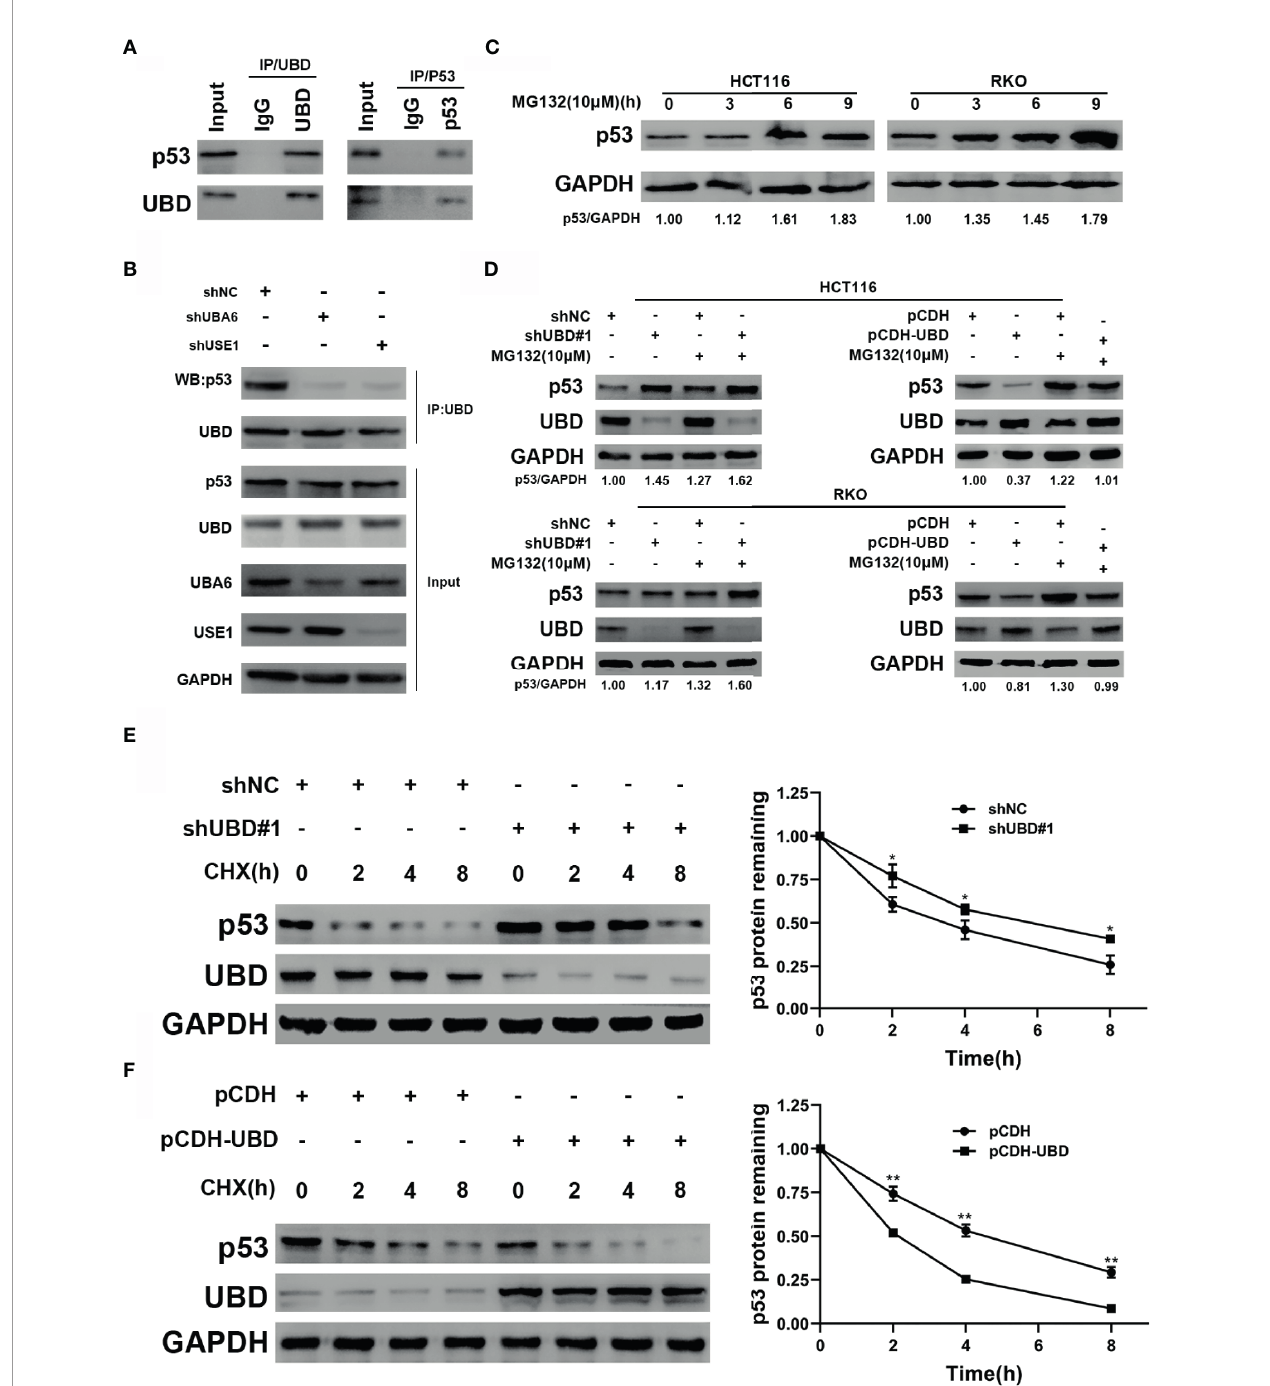
FIGURE 6 | UBD inhibits p53 stability by enhancing the protein degradation of p53. (A) Immunoprecipitaion of endogenous UBD and p53 in HCT116 cells. (B) UBD-p53 complexes were examined in HCT116 cells transfected with the indicated shRNAs (C) Western blot analysis of p53 expression in cells treated with MG132 (10 m M) for the indicated times. (D) After transfection with the shNC, shUBD#1, pCDH or pCDH-UBD plasmids, p53 expression in HCT116 and RKO cells was observed upon addition of MG132 (10 m M) for 6 hours by using Western blotting. (E , F) HCT116 cells were transfected with shNC or shUBD#1 (E) , RKO cells were transfected with pCDH or pCDH-UBD (F) . Then treated with 100 m g/mL CHX for the indicated times. Western blotting was used to detect the UBD and p53 expressions. Quantitative analysis was conducted on p53 level in Western blotting, the half-life time of p53 was calculated (* p < 0.05; ** p < 0.01). GAPDH was used as an endogenous control. CHX,